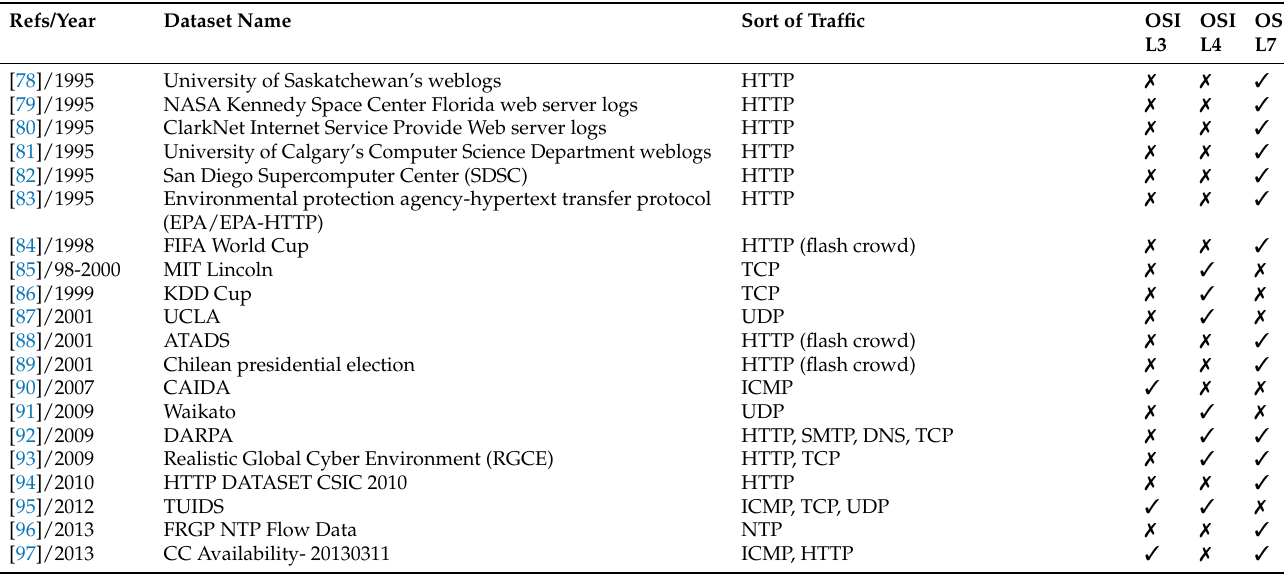
Table 7. DDoS attack